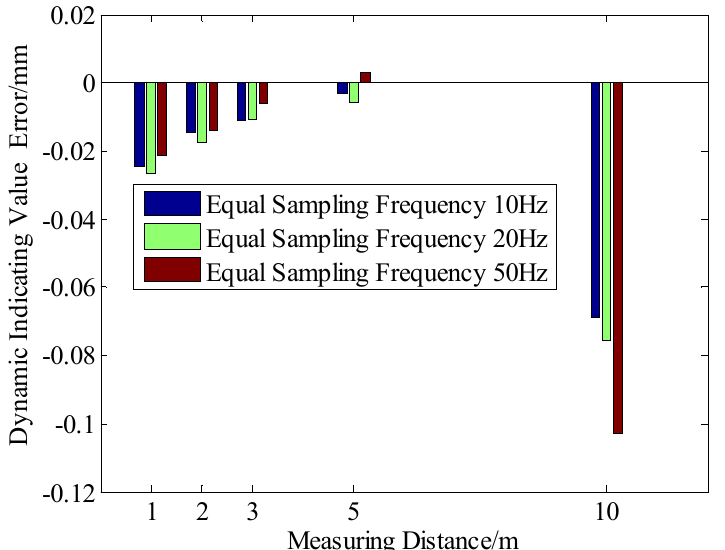
Figure 10. Measurement distance and dynamic display error diagram—(equal sampling fre- quency).